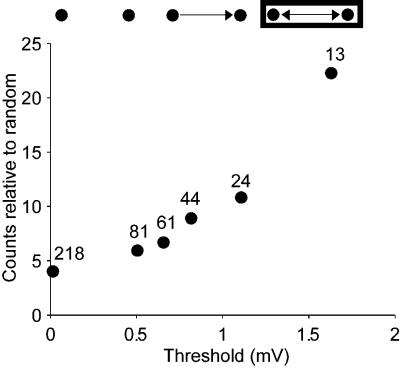
Stronger Connections Are More Likely Reciprocal than Weaker OnesOverrepresentation of bidirectionally connected motifs gets more dramatic for higher threshold of connection strength (counts differ from random with p < 0.001 for all thresholds, Monte Carlo simulation). Significance of monotonicity is assessed by applying the Kolmogorov-Smirnov test (p < 3.5 × 10−10 for all successive pairs). Numbers on top of dots show the counts of actual pairs.